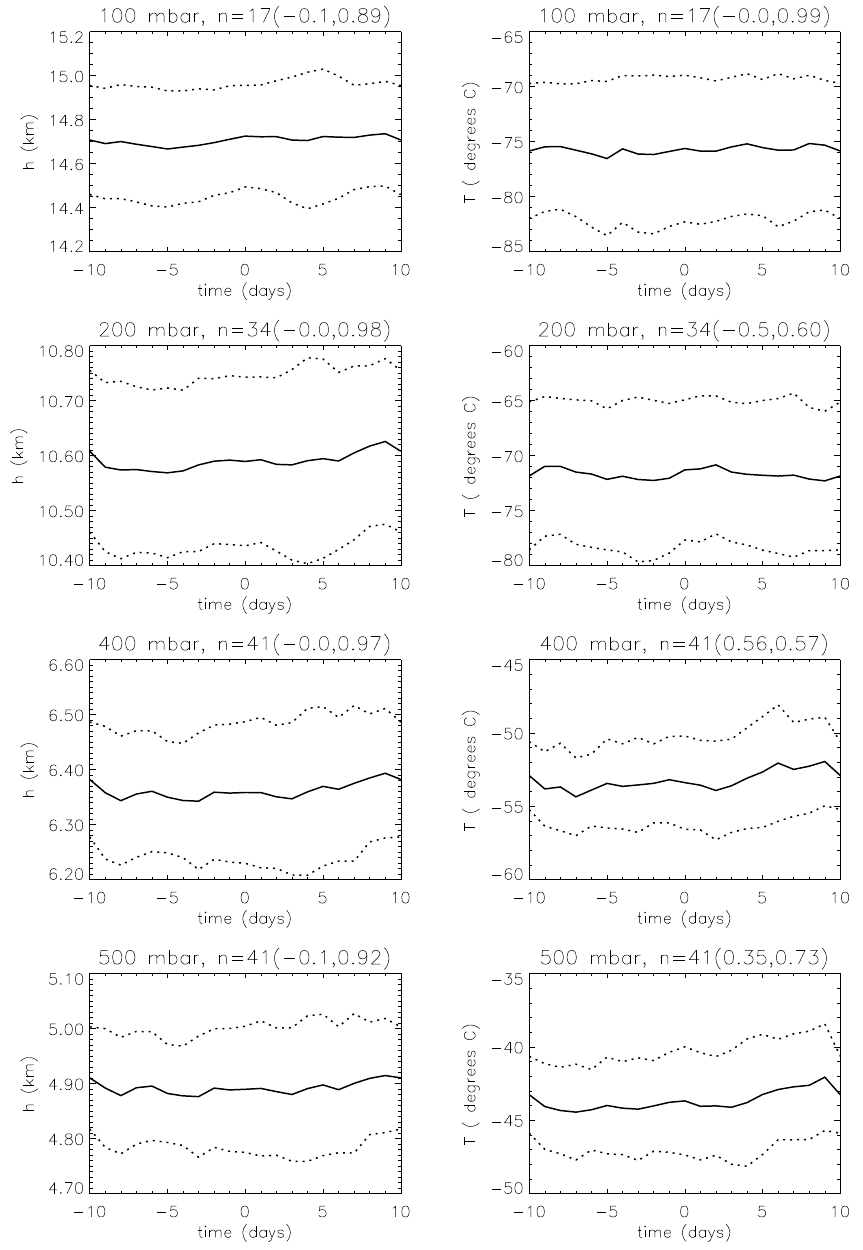
Fig. 1. Superposed epoch analyses of the winter isobaric height and temperature, at pressures of 100mbar, 200mbar, 400mbar and 500mbar, with those for isobaric height in the left-hand column and those for isobaric temperature in the right-hand column. t = 0 is the start time for each of n geomagnetic storm events that meet the data selection criteria. The solid line in each plot represents the superposed epoch analysis and the dashed lines have been placed a standard deviation above and below the resulting superposition. The title of each plot gives the pressure level, the number of events used in the superposition and, in brackets, the t -test statistic and its significance for the difference between the mean values on days − 1 and +